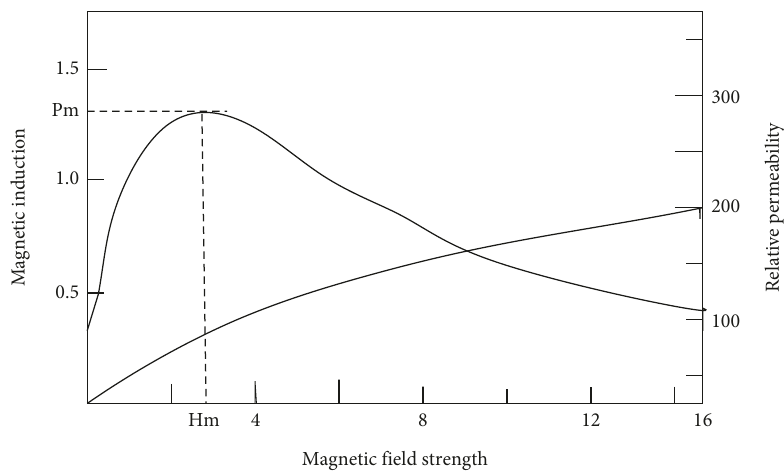
Figure 3: Magnetization characteristic